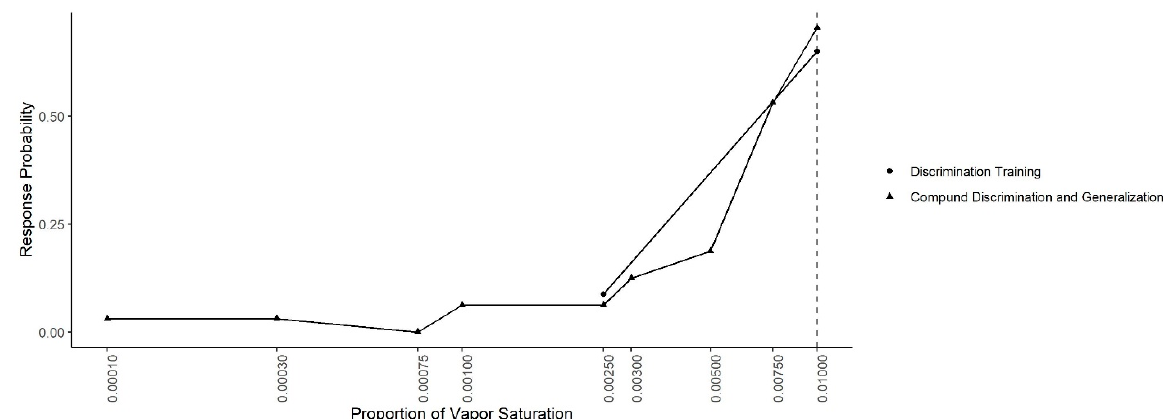
Figure 7. Concentration Discrimination and Compound Generalization. The response probability for the last two sessions of the discrimination training phase (0.01 vs. 0.0025) and the Compound Discrimination and Generalization test. Dashed line shows the target odor concentration.